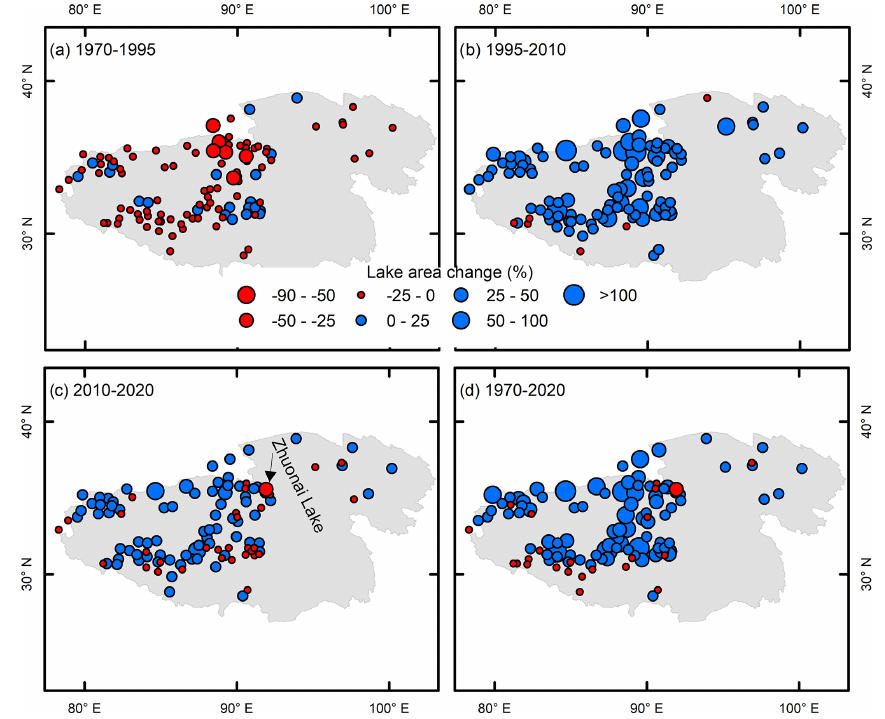
Figure 10. Spatial patterns of lake area changes during the Landsat era. (a) 1970–1995. (b) 1995–2010. (c) 2010–2020. (d) 1970–2020.